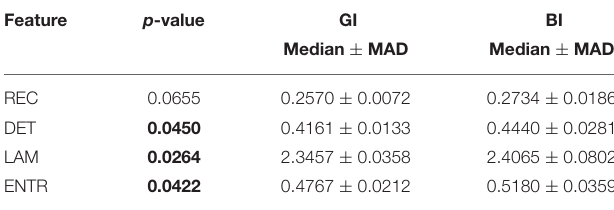
TABLE 5 | Statistical comparison between BI and GI considering only the difficult task.